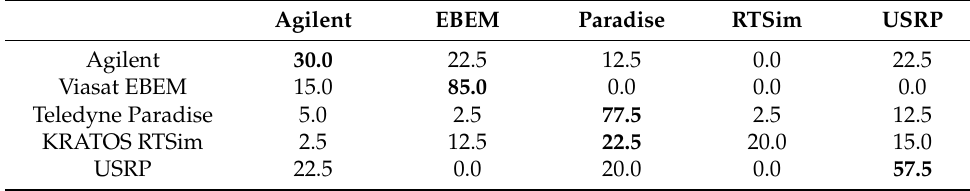
Table 3. Reduced data set Table 2 @ SNR = 15 dB.